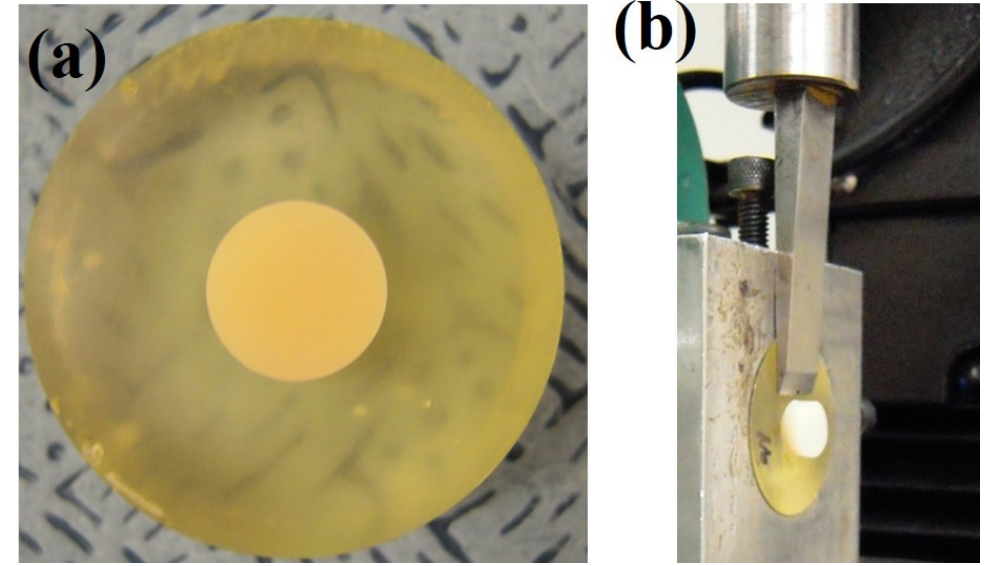
Figure 2. The photographs showing; ( a ) shear bond strength test specimen; ( b ) actual test carried